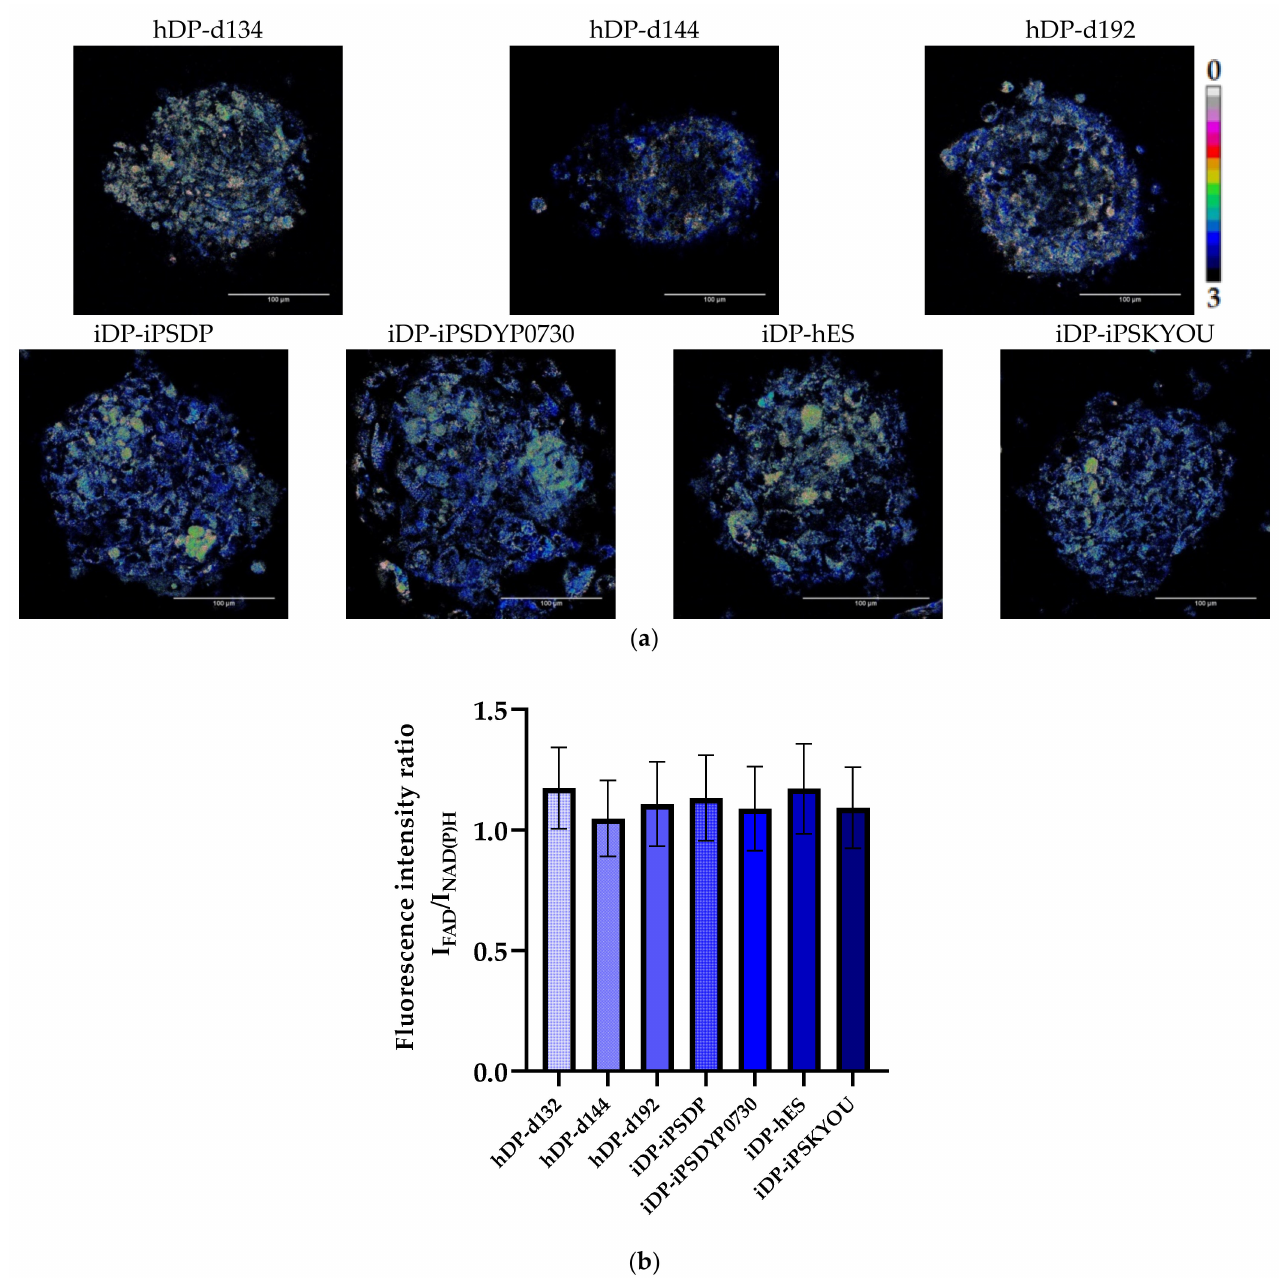
Figure 6. ORR analysis of the hDP spheroids, created from hDP-d134, hDP-d144, and hDP-d192 lines, and iDP spheroids, created from iDP-iPSDP, iDP-iPSDYP0730, iDP-hES and iDP-iPSKYOU lines. ( a ) Images of the fluorescence intensity ratio FAD to NAD(P)H in hDP and iDP spheroids (the scale length in all pictures is 100 µ m). ( b ) Values of the fluorescence intensity ratio FAD to NAD(P)H in hDP and iDP spheroids (mean ±